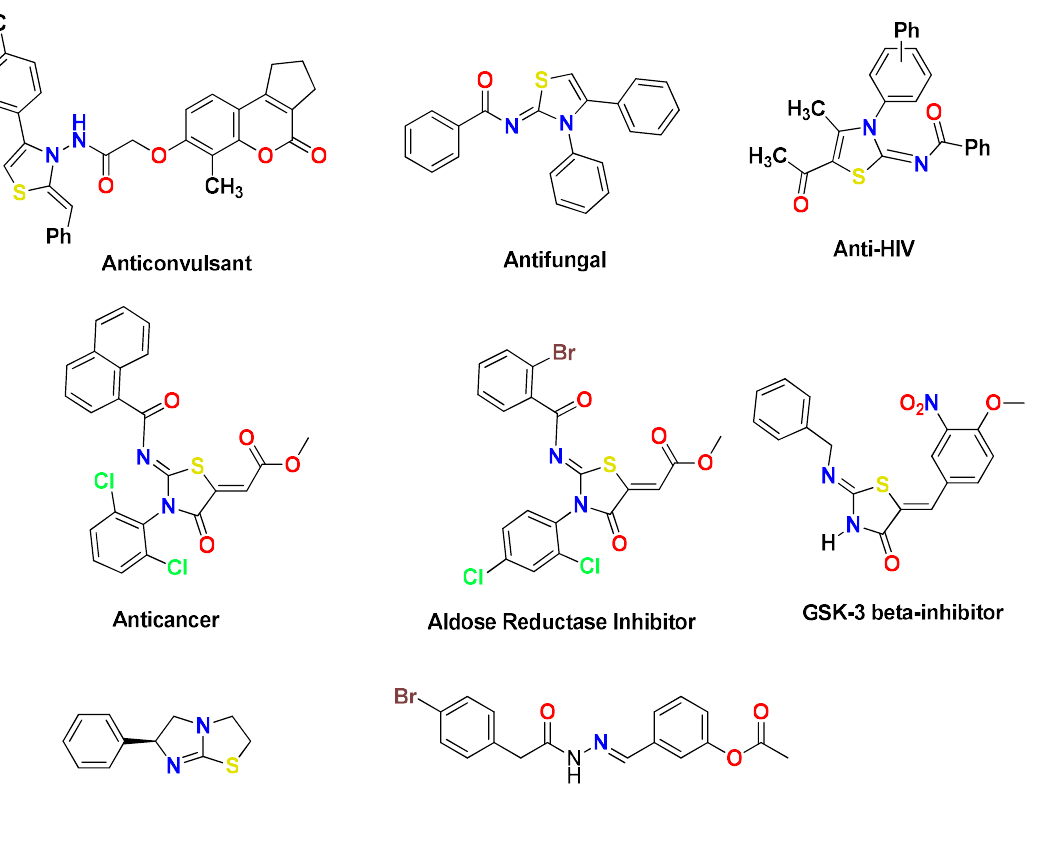
Figure 1. Chemical structures of pharmacologically important compounds [33–36].